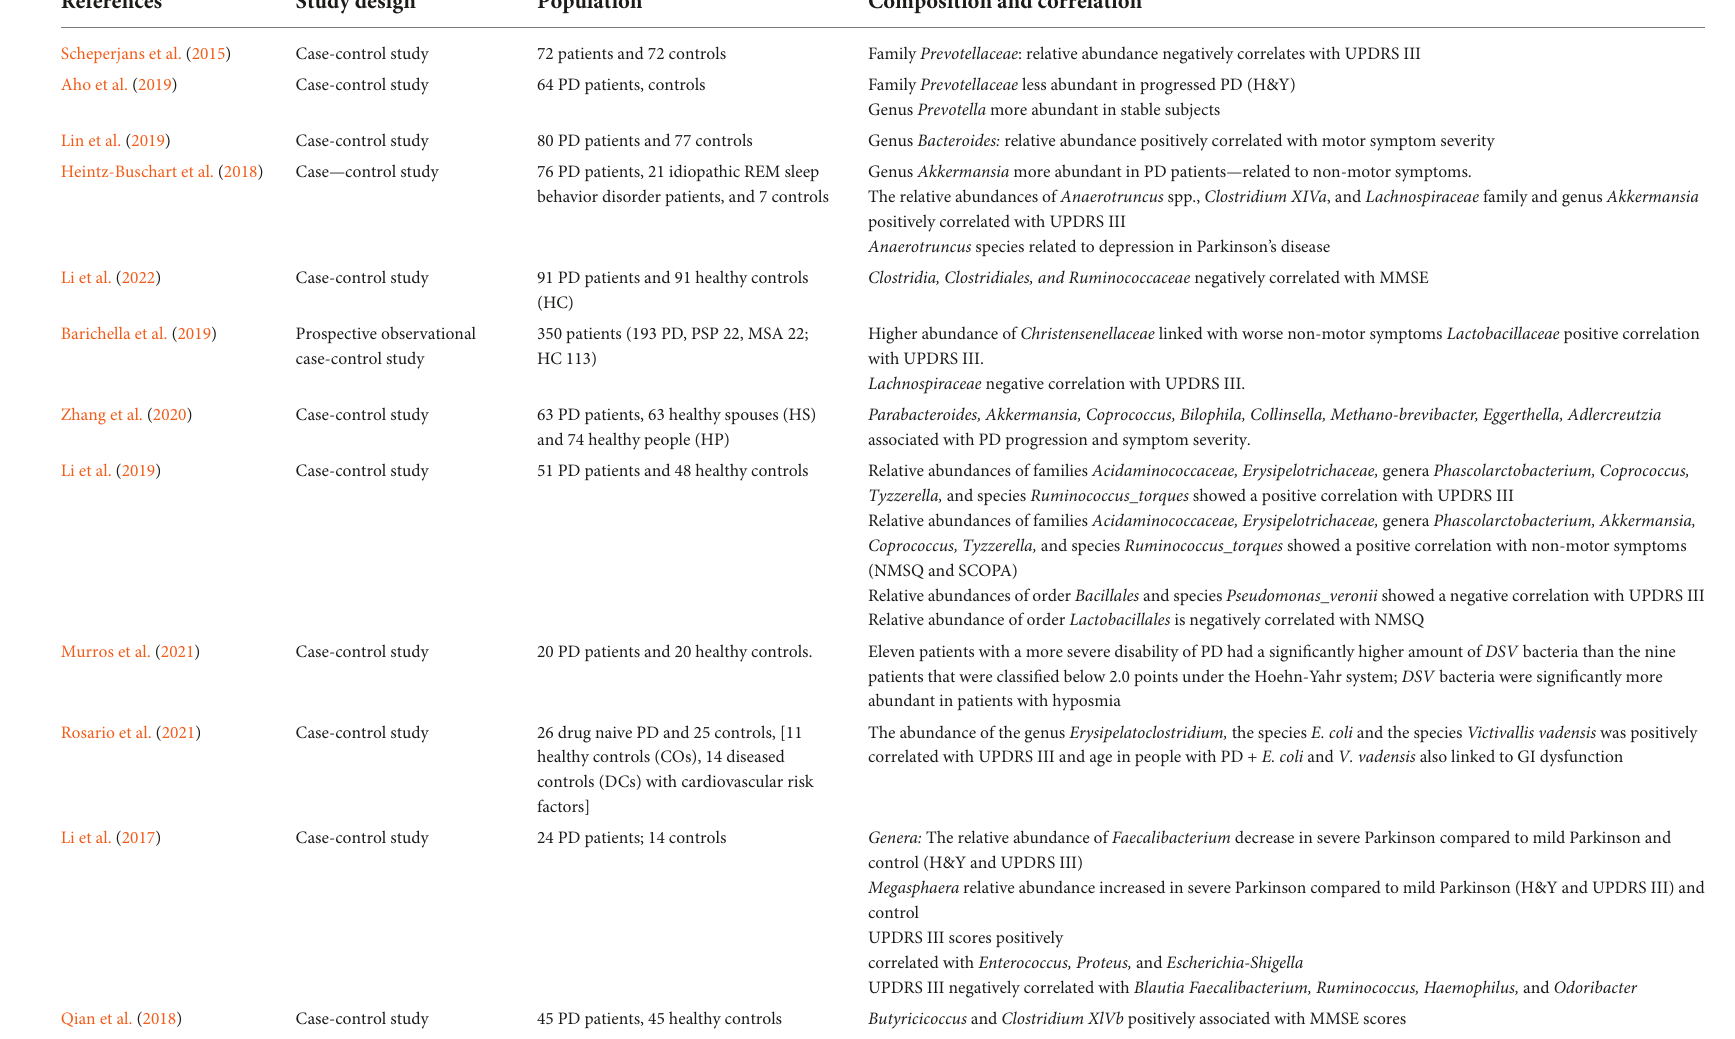
TABLE 1 Cited studies listed by study